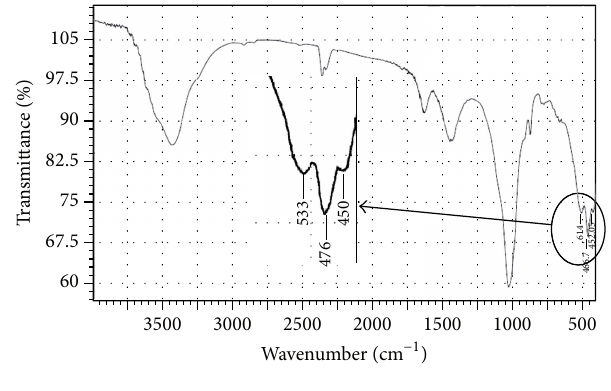
F 3: FTIR spectrum for raw